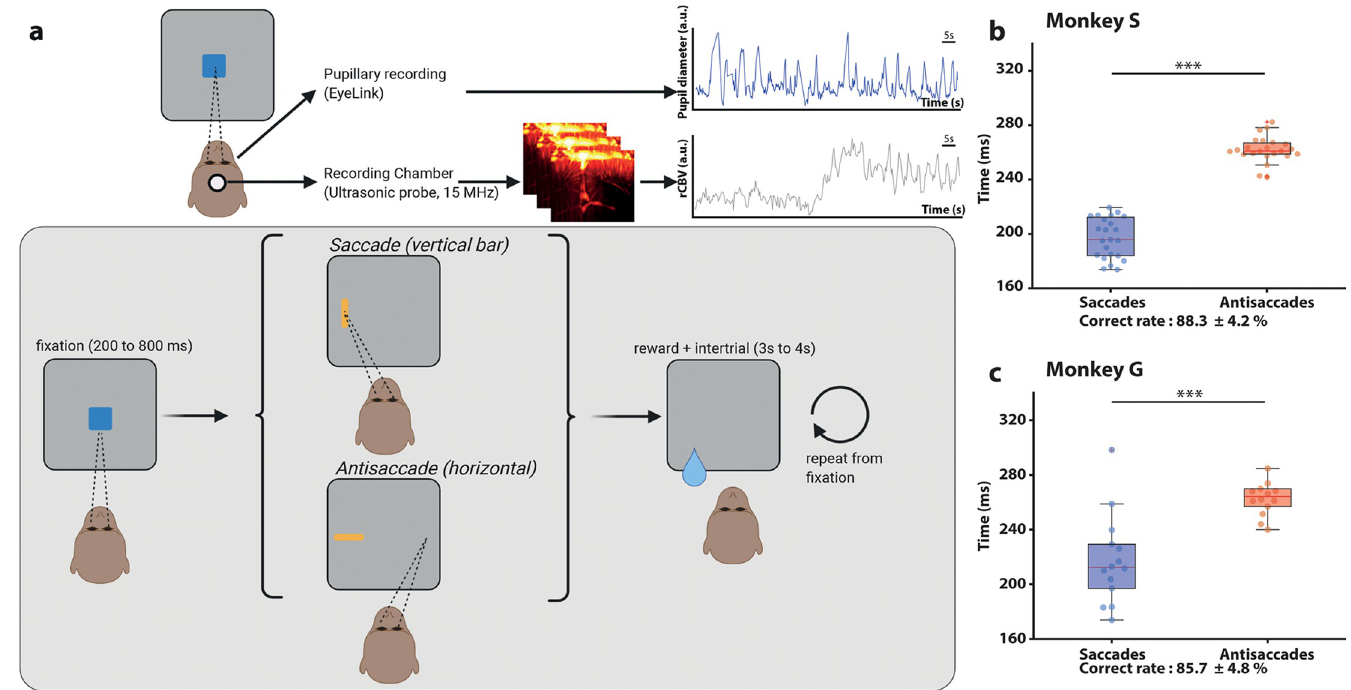
Fig 1. Task timeline. AU : AbbreviationlisthavebeencompiledforthoseusedinFigs 2 ; 4 ; andS 1 : Pleaseverifythatallentriesarecorrect : (a) The heads of the monkeys are fixed in a chair with a 15-MHz ultrasonic probe in a recording chamber. An EyeLink recording system records the eye position and pupillary diameter in real time. During the task, there is a baseline of 200 to 220 s (randomized) and a fixation point is shown. If the animal succeeds, a prosaccade (vertical rectangle) or an antisaccade (horizontal rectangle) is shown on the screen. Based on the cue, the animal performs a saccade or an antisaccade and, if he succeeds, receives a reward associated with a specific color of the fixation point (red: 0.5 times the normal reward, blue: 1 time the normal reward, green: 1.5 times the normal reward). This action is followed by a gray screen of 3 to 4 s (randomized) used as an intertrial before repeating from the fixation point. (b) The average saccade response time for Monkey S for all sessions was 197.0 ± 15 ms, and the antisaccade response time 262.0 ± 10 ms, with a total correct rate of 88.2 ± 4.2%. (c) The average saccade response time for Monkey G was 218 ± 32 ms, and the antisaccade response time 267 ± 24 ms, with a correct rate of 85.7 ± 4.6%. The data underlying the graphs shown in the figure can be found in https://osf.io/2q357/.